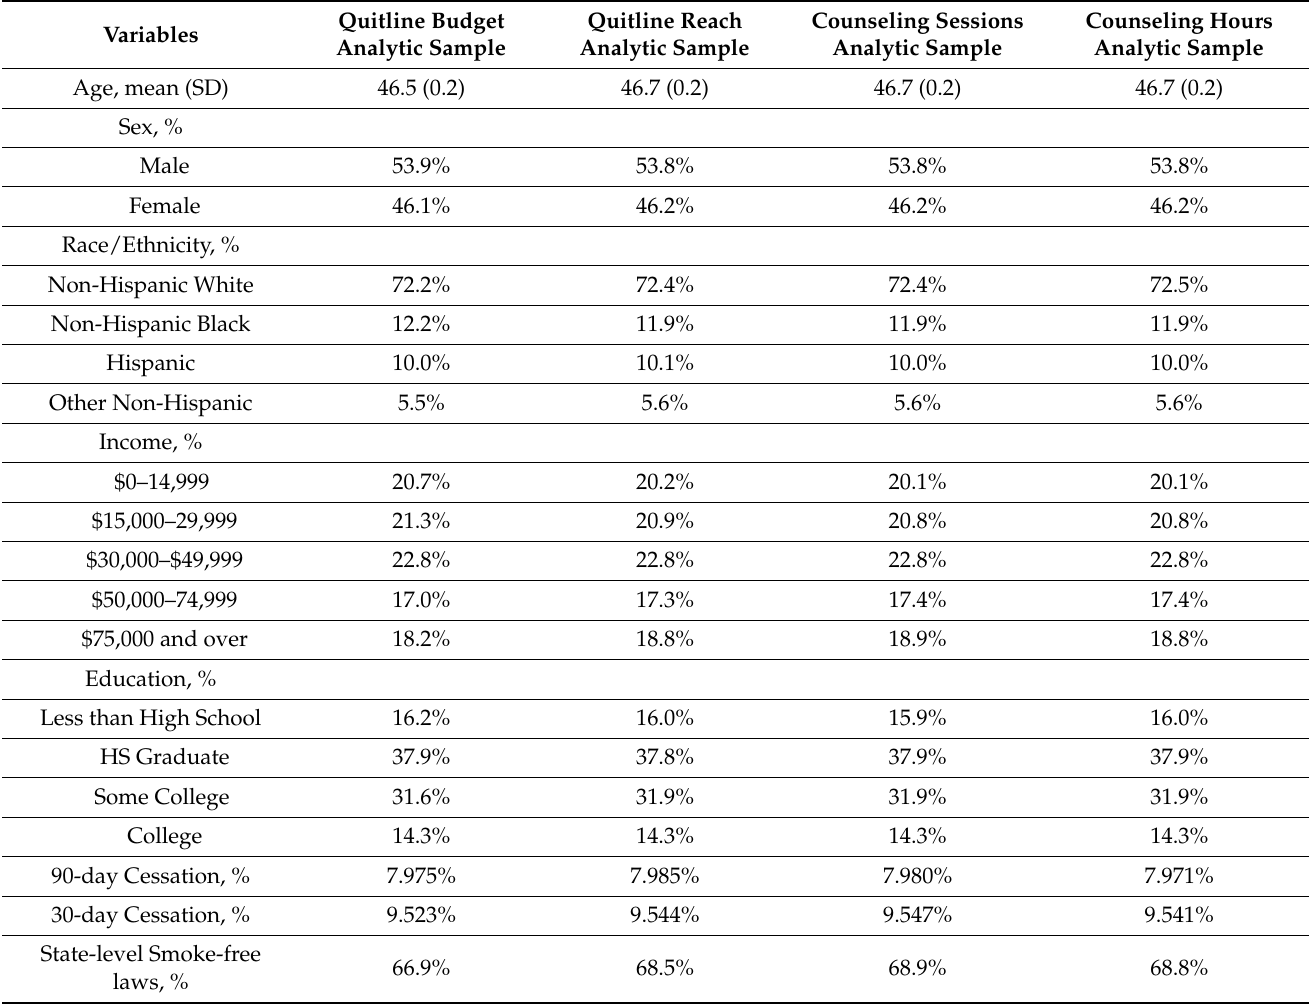
Table 1. Weighted characteristics of quitline budget, quitline reach, counseling sessions, and counseling hours analytic samples, Tobacco Use Supplement to Current Population Survey,